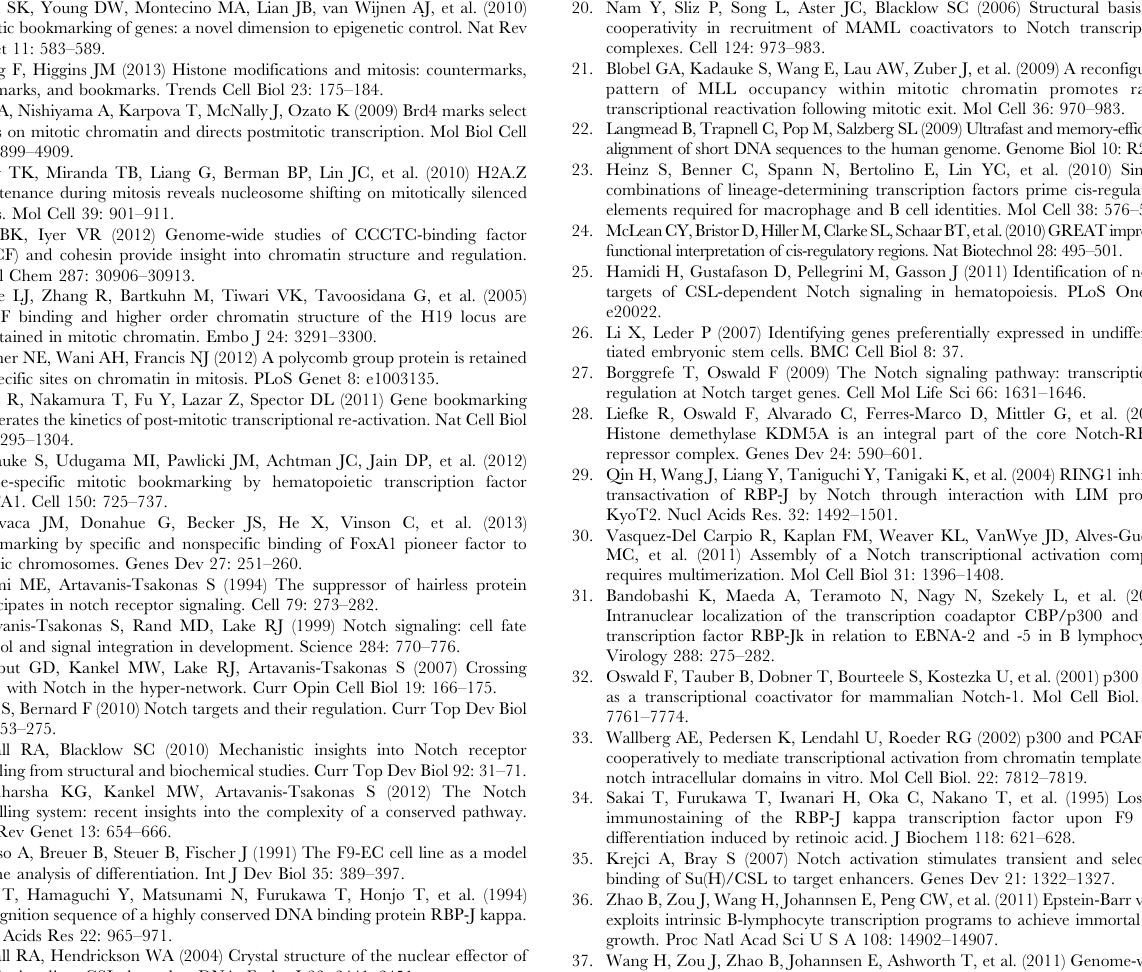
Table S5 GO analysis of RBPJ binding peaks in mitotic F9 cells.